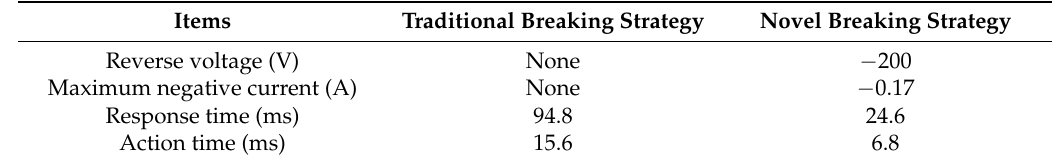
Table 1. Experimental